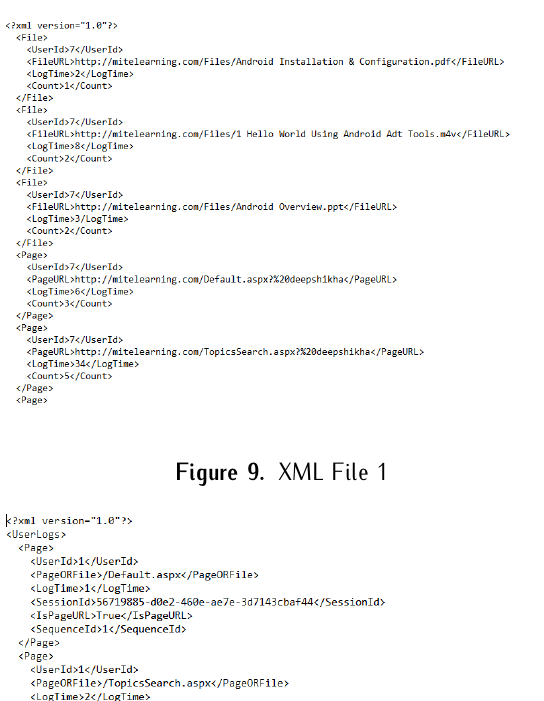
Figure 8. File Table